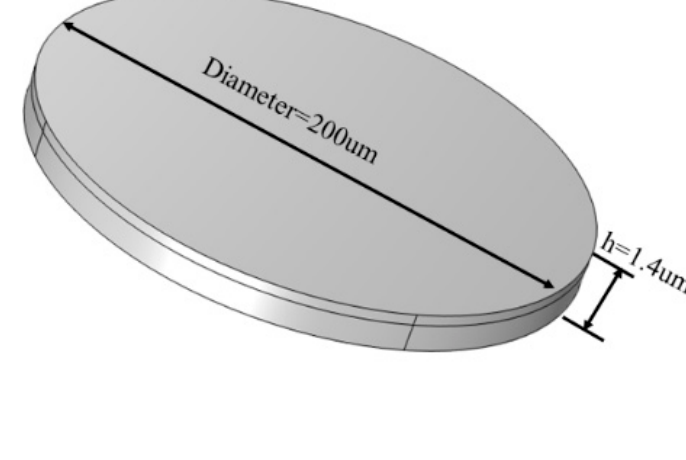
Figure 5. Antenna Figure 5. Antenna model.